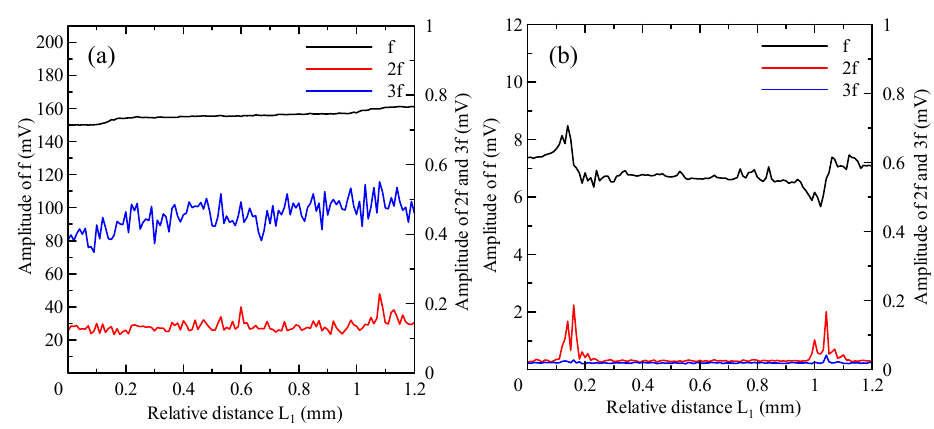
Fig. 6 Output amplitude of (a) Receiver 1 and (b) Receiver 2 for 50 kPa, liquid